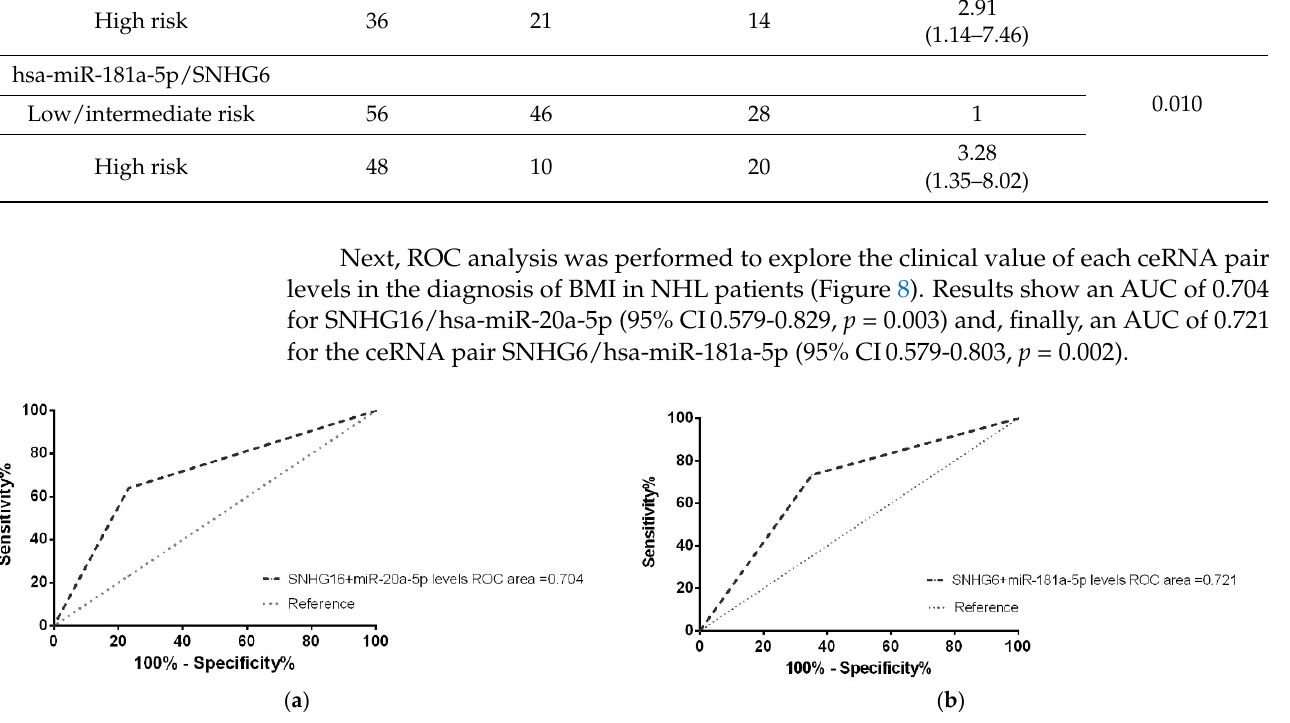
Figure 8. Plasma levels of ceRNA pair as biomarkers of BM involvement in NHL patients. ROC curve analysis of plasma levels of ( a ) SNHG16/hsa-miR-20a-5p and ( b ) SNHG6/hsa-miR-181a-5p ceRNA pair as diagnostic biomarkers differentiating positive BM involvement patients from negative BM involvement patients. BM involvement